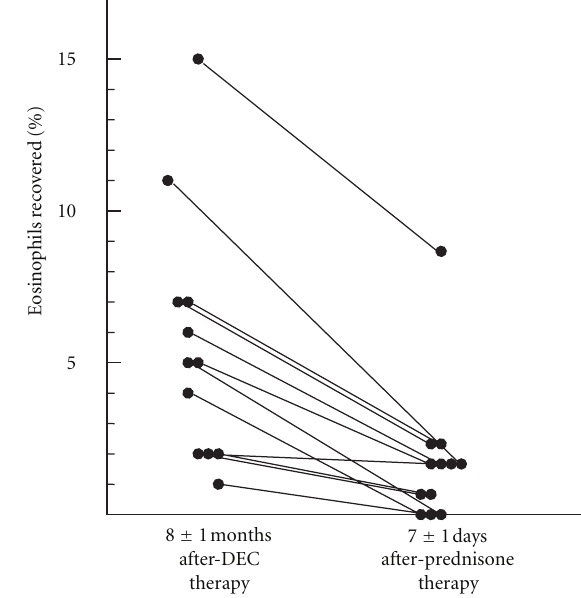
Figure 1: Suppression of lung eosinophils with prednisone in TPE patients following after diethylcarbamazine therapy. 7 ± 1 days after prednisone therapy there was a reduction in the percent of eosinophils observed in 12